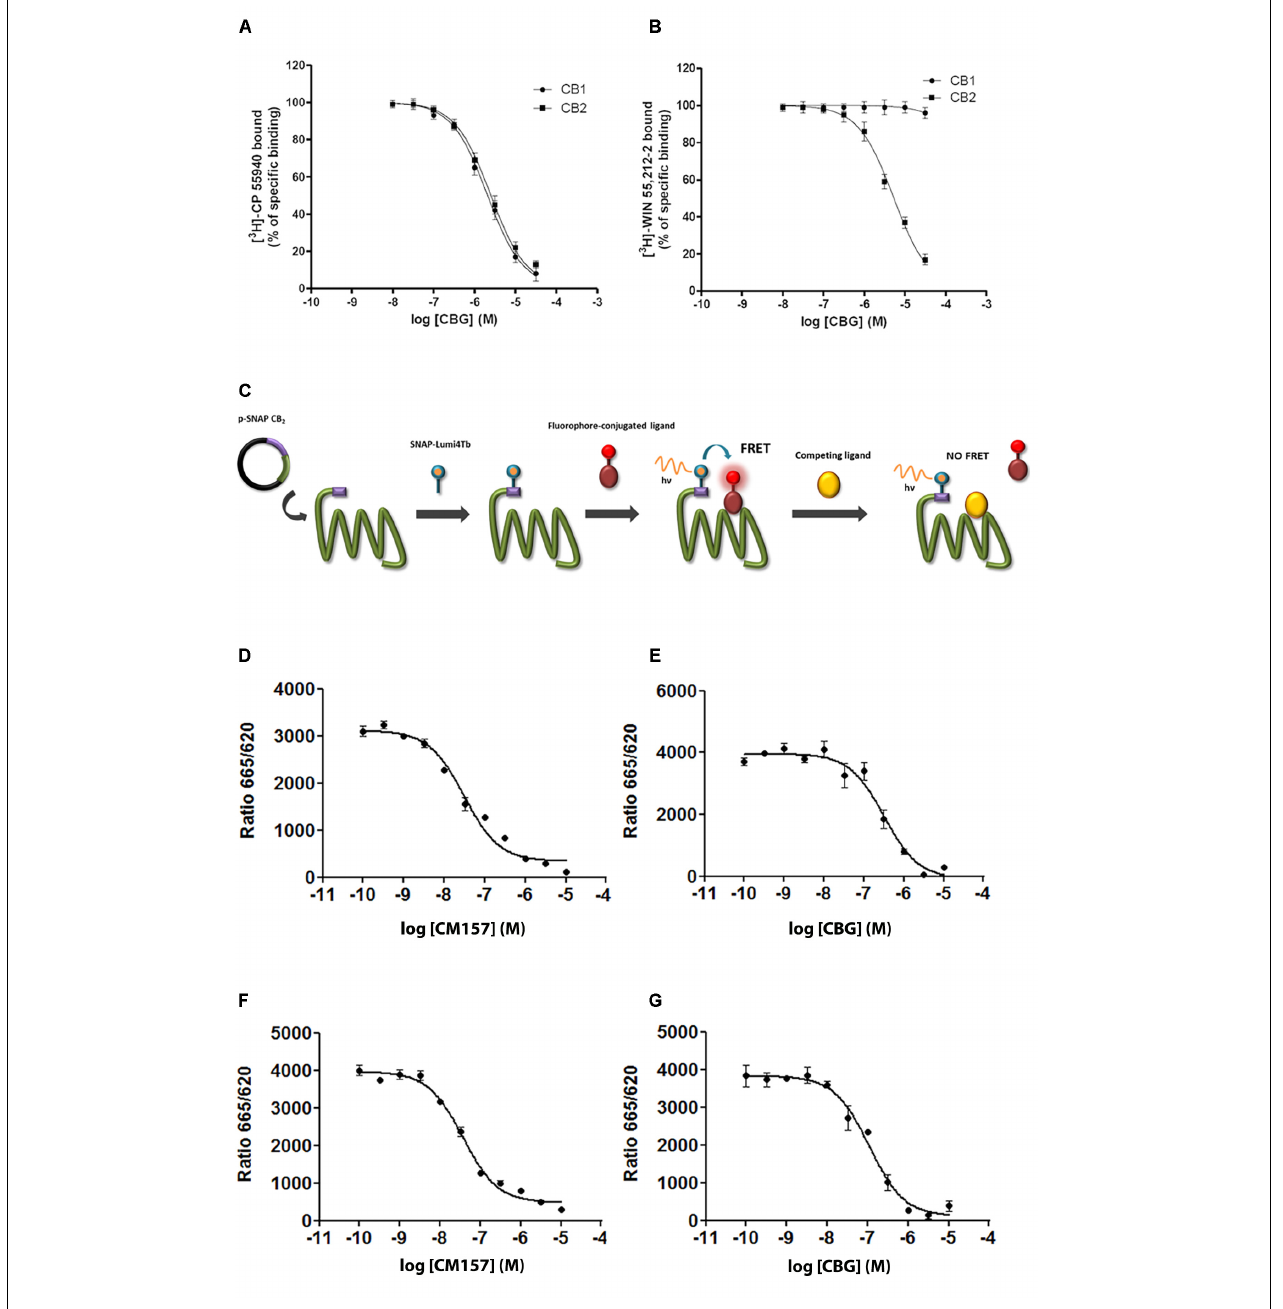
FIGURE 2 | Competition by CBG of agonist binding to CB 1 R and/or CB 2 R. (A,B) Competition curves for CBG in radioligand-based assays using either [ 3 H]-CP-55940 (A) or [ 3 H]-WIN-55,212-2 (B) binding on membranes from CHO cells stably expressing human CB 1 R or CB 2 R. (C) Scheme of the HTRF-based competitive binding assay. The GPCR of interest with the SNAP-tagged enzyme fused to its N-terminal domain is expressed at the cell surface. SNAP is a commercially available tag consisting of circa 180 amino acids, that can be labeled with fluorophores or other probes in a covalent fashion. The GPCR–SNAP-tagged cells are subsequently labeled with a Tb-containing probe (SNAP-Lumi4-Tb) through a covalent bond between the Tb and the reactive side of the SNAP enzyme. The Tb acts as FRET donor of an acceptor covalently linked to a selective CB2 receptor ligand. Thus, upon binding of a fluorophore-conjugated ligand (FRET acceptor) on the donor-labeled SNAP-tagged/GPCR fusion protein, an HTRF signal from the sensitized acceptor can be detected since the energy transfer can occur only when the donor and the acceptor are in close proximity. In competition binding assays using CM-157, the unlabelled specific ligand competes for receptor binding site with the fluorophore-conjugated ligand, leading to a decrease in the HTRF signal detected. (D–G) HEK-293T were transiently transfected with 1 µ g cDNA for